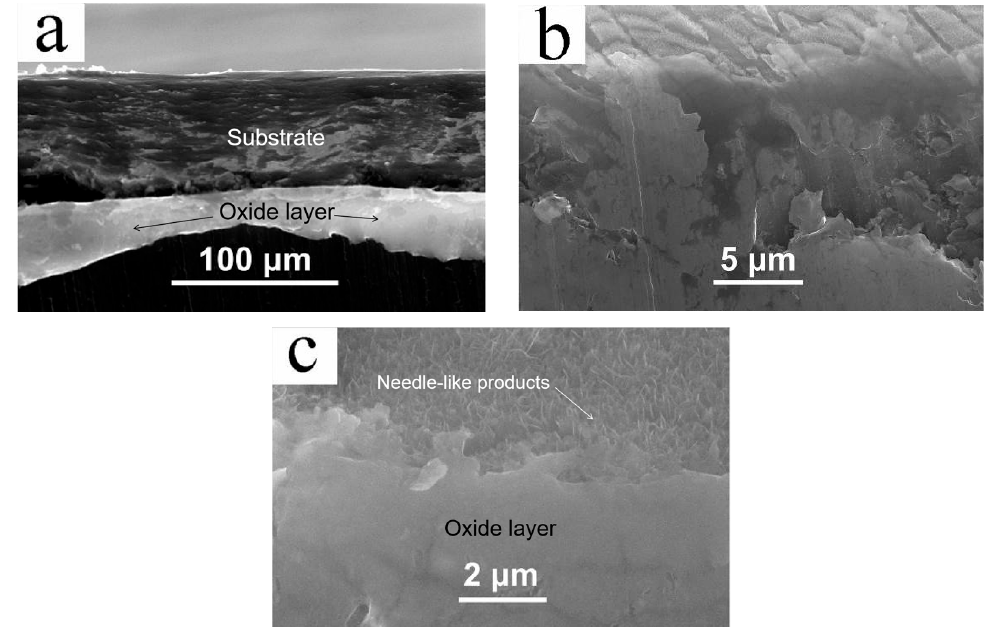
Figure 5. Cross-sectional view of an aluminum sheet corroded under high-temperature water vapor at 700 °C: ( a ) Aluminum sheet overall structure; ( b ) Bonding site of oxide layer and substrate; ( c ) Below the oxide surface layer.